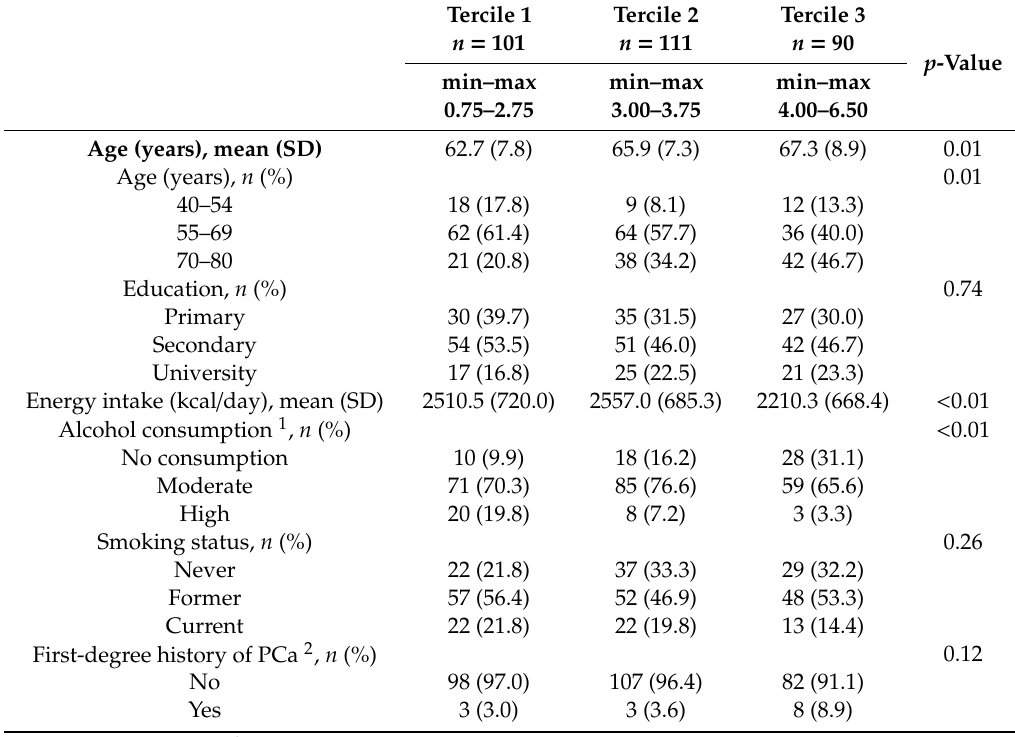
Table 3. Characteristics of participants in the control group according to terciles of the 2018 WCRF / AICR score in CAPLIFE